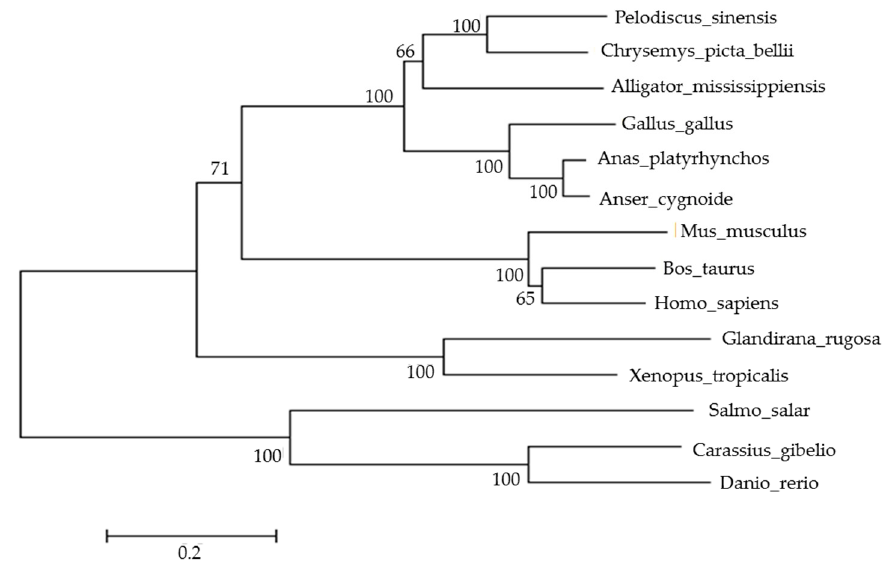
Figure 2. A phylogenetic tree of AMH amino acid sequence among various species. The AMH sequences from other species were constructed by using the maximum likelihood method. The bootstrap sampling was performed with 1000 replicates and the numbers at the forks indicate the bootstrap proportions. The scale bar represents the expected number of amino acid substitutions per site.